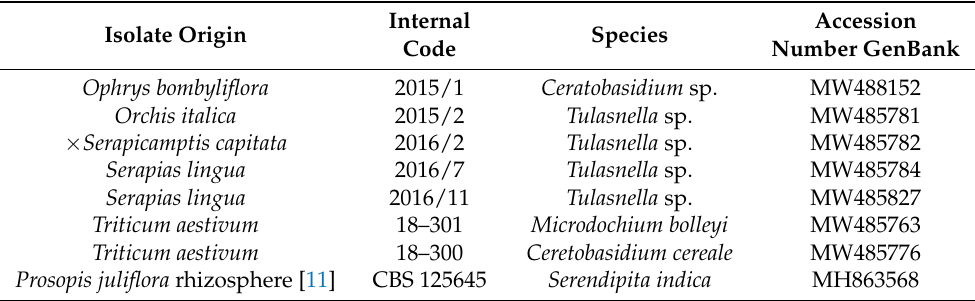
Table 6. The origin of endophytic isolates used as individual treatments, internal code, species according to the internal transcribed spacer and accession number in the genetic sequence